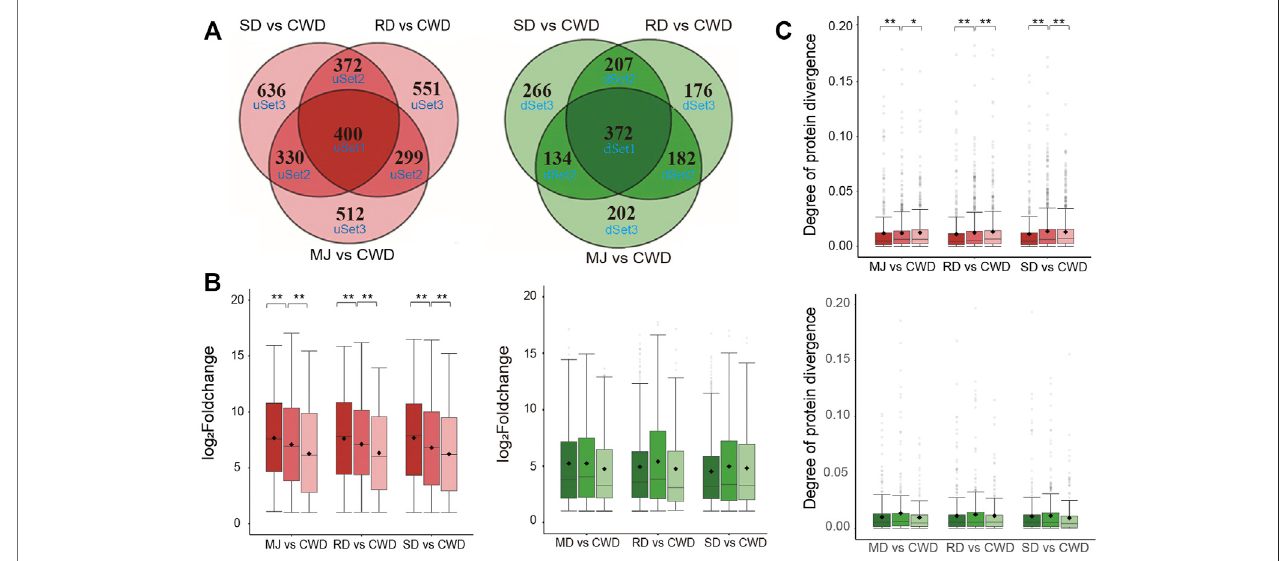
FIGURE3|(A) Venndiagramoftheupregulated(red) anddownregulated(green)genesofthree comparative groupsrespectivelybasedontheoverlap level.Note thatthehighertheoverlaplevel,thehigherco-expresseddegreeofthegenes. (B) Boxplotofthechangesingeneexpressionintheupregulated(red)anddownregulated (green) gene sets of each of three comparative groups, respectively. Wilcox test ** p < 0.01 and * p < 0.05. (C) Boxplot of the degree of protein divergence (non- synonymousmutationrate(Ka)) ofdeer-orthologs in theupregulated (red) anddownregulated (green)genesets ofeach ofthreecomparative groups,respectively. Wilcox test ** p < 0.01 and * p <